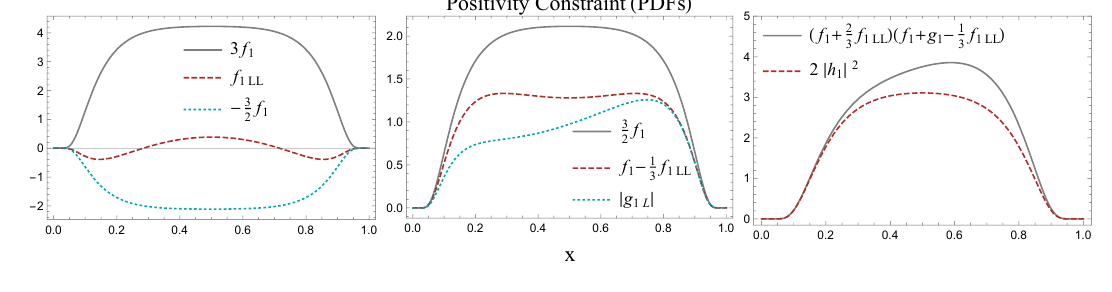
Figure 8 . Several positivity constraints on PDFs plotted with respect to x